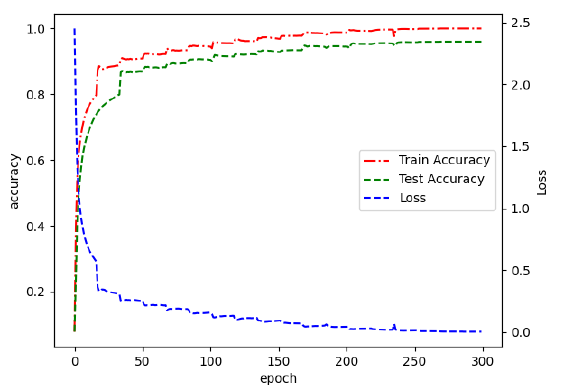
Figure 7. Learning